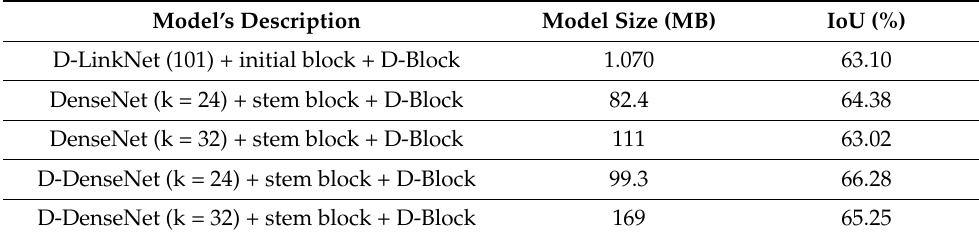
Table 2. Results using the public dataset for selected